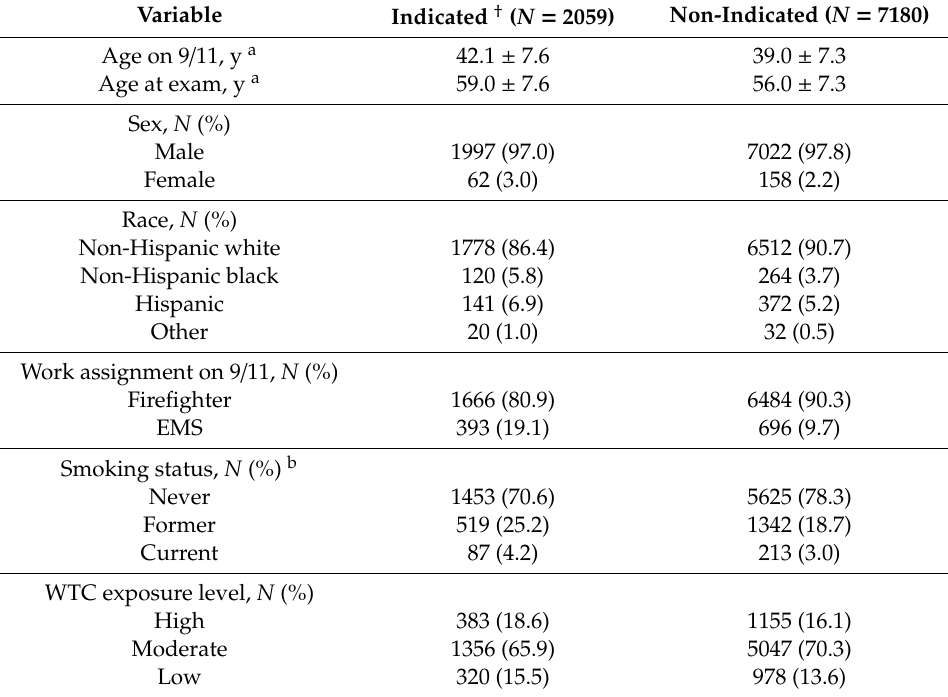
Table 1. Demographic characteristics among individuals 40 years and older (7 June, 2017–6 April,